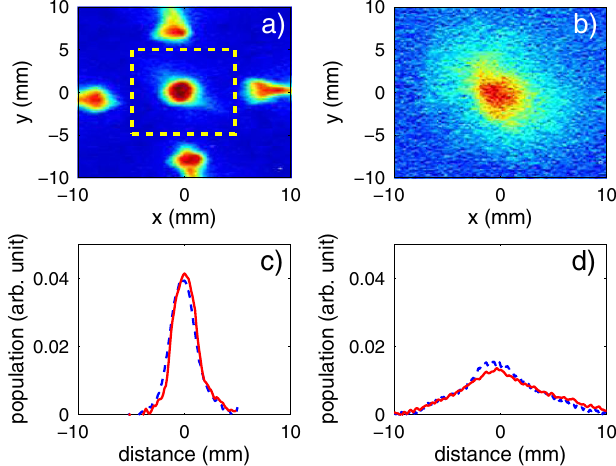
FIG. 6. (Color) Measured two-dimensional transverse beam density at YAG1 location and corresponding horizontal (blue dashed line) and vertical (red solid line) projections for the cases with [ Q ¼ 0 : 93 (cid:9) 0 : 05 nC ] [(a),(c)] and without [(b),(d)] [ Q ¼ 0 : 17 (cid:9) 0 : 03 nC ] surrounding beamlets. The dashed box in (a) represents the region of interest used to compute the projections displayed in (c). The magnetic field is ^ B ¼ 0 : 376 T .